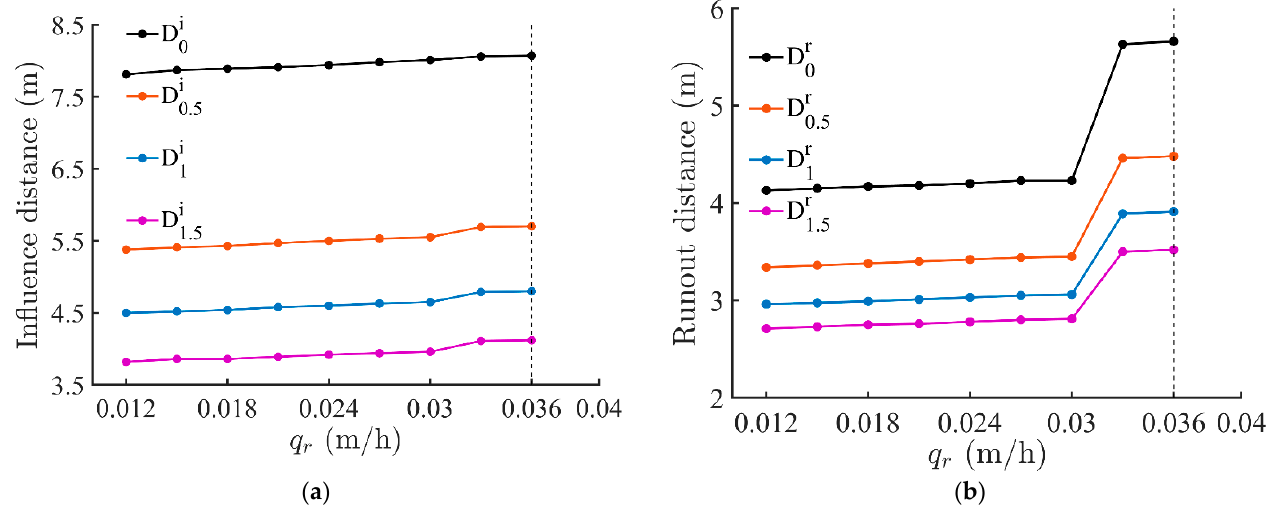
Figure 17. Variations in influence distances and runout with different rainfall intensities: ( a ) different influence distances in uniform slopes; ( b ) different runout distances in uniform slopes.